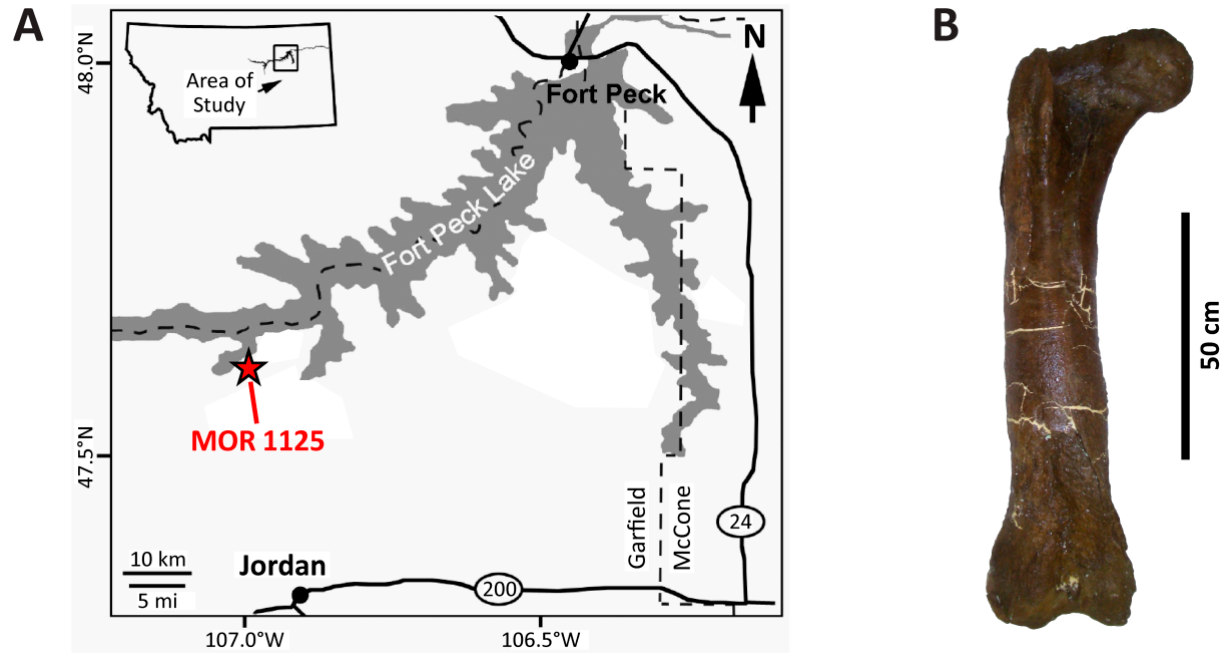
Figure 1. ( A ) Map showing the location of the MOR 1125 quarry in Garfield County, Montana. ( B ) Right femur of MOR 1125 examined in this study. Map modified from [54] and bone photograph modified from [55], each under CC BY-4.0 licenses.